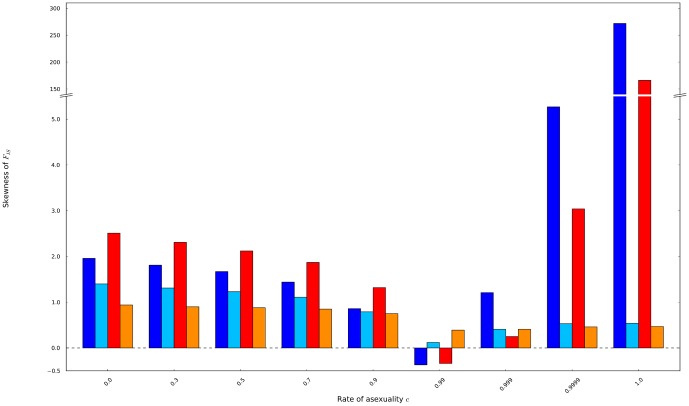
The skewnesses of the possible distributions of F
IS were obtained from populations of 60 individuals mutating at a rate of 10−8 (dark blue) and 10−3 (light blue), and from populations of 140 individuals mutating at a rate of 10−8 (red) and 10−3 (orange).